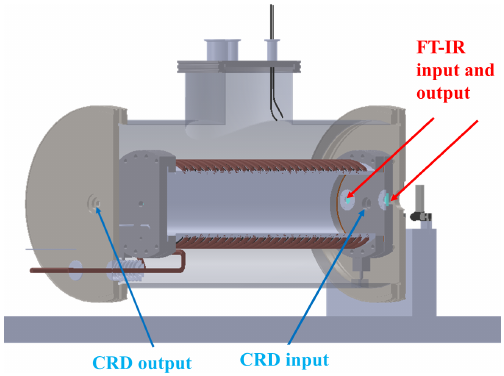
Figure 3. Position of the windows dedicated to FTIR spectroscopy (red arrows) and to the CRD experiment (blue